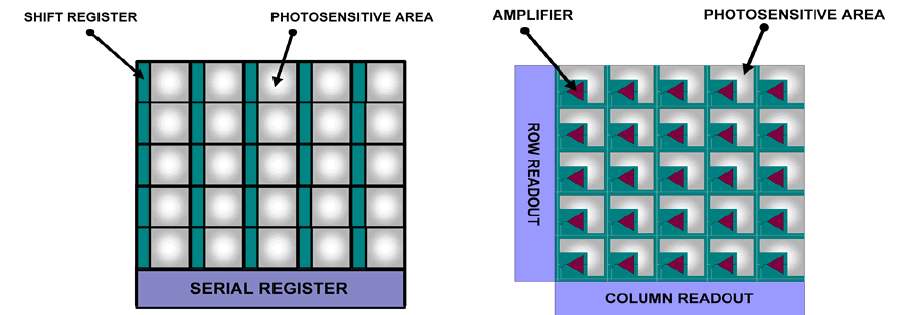
Figure 36. Comparison of CCD (left) and CMOS (right) cameras.